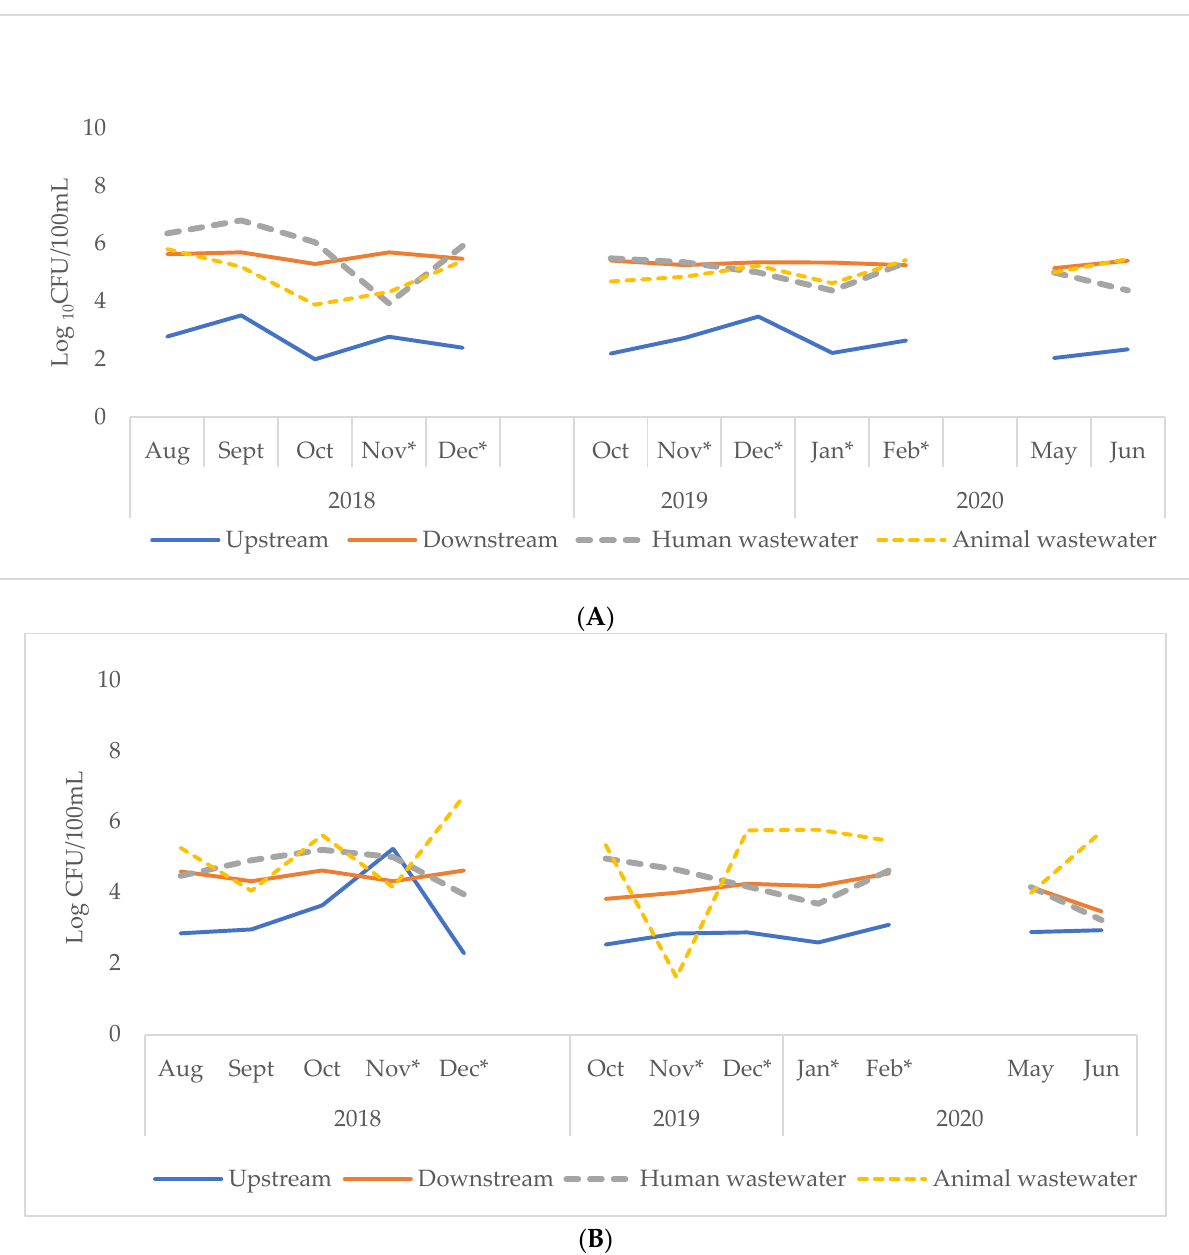
Figure 4. Log concentration of ESBL-Ec in sampling sites in Accra ( A ) and Kasoa ( B ) for the periods: August 2018–December 2019, October 2019–February 2020, May, June 2020. * Indicates dry season, ESBL-Ec = Extended-Spectrum Beta-Lactamase E. coli , CFU = colony-forming units.